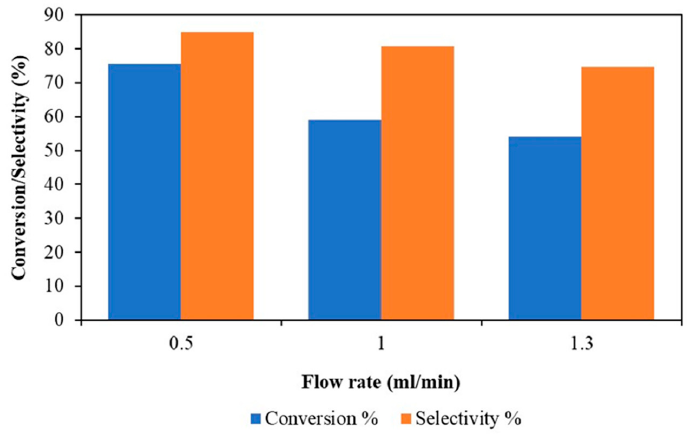
Figure 11. E ff ect of the flow rate at the same speed of agitation for three phases. Epichlorohydrin 0.1 mol, n-decane 0.03 mol, toluene 150 cm 3 , guaiacol 0.1 mol, sodium hydroxide 0.2 mol, sodium chloride 0.6 mol, tetra-n-butylammonium bromide 0.14 mol, and water 150 cm 3 . Temperature 40 ◦ C, speed of agitation 60 rpm for all three phases, and reaction time 6 h.